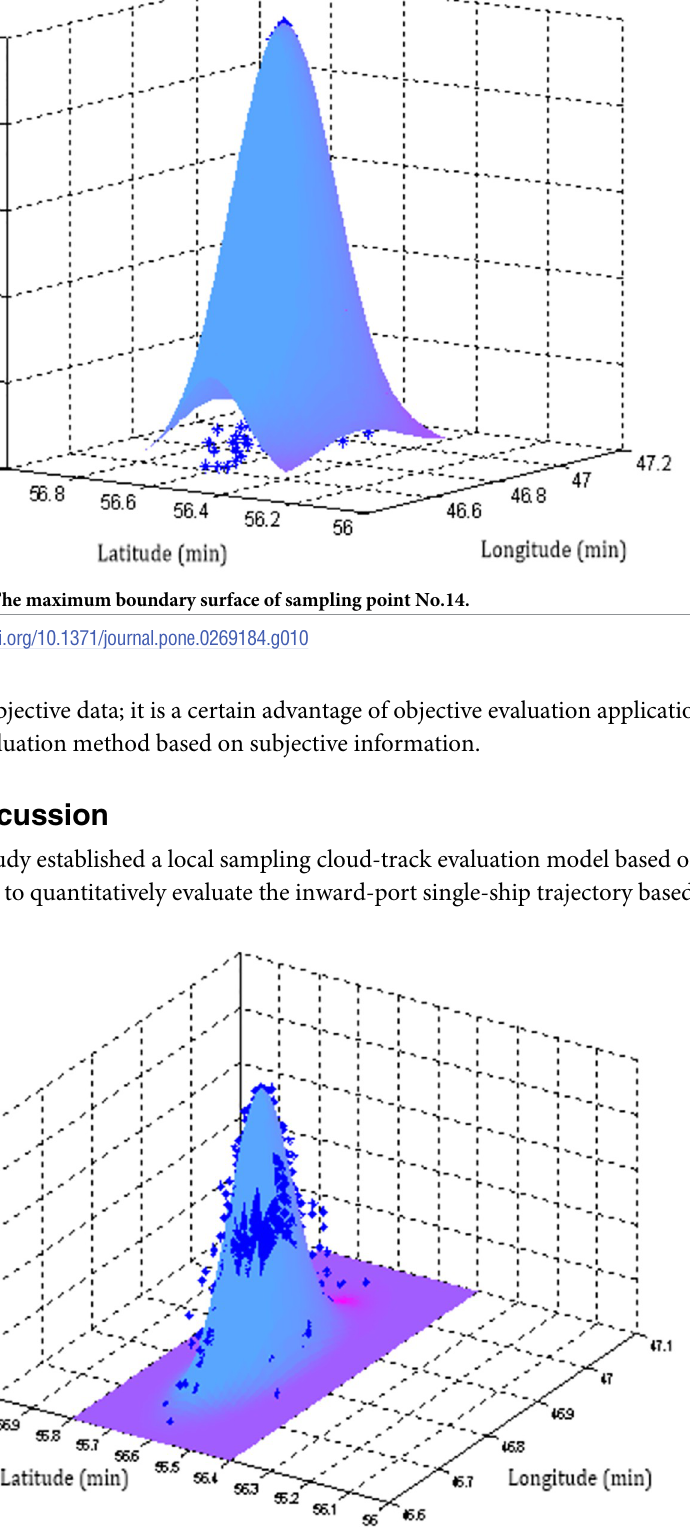
Fig 11. Corrected expected surface of sampling point